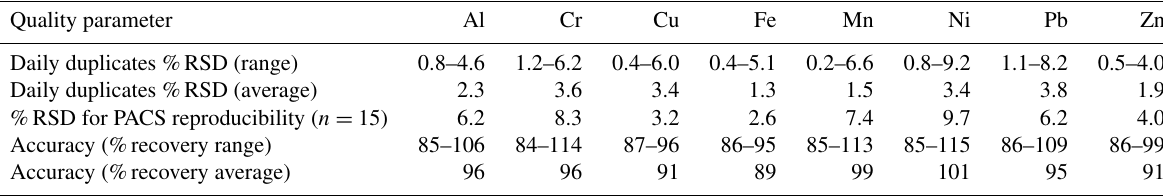
Table A1. Quality control data for total metal analyses. Quality parameter